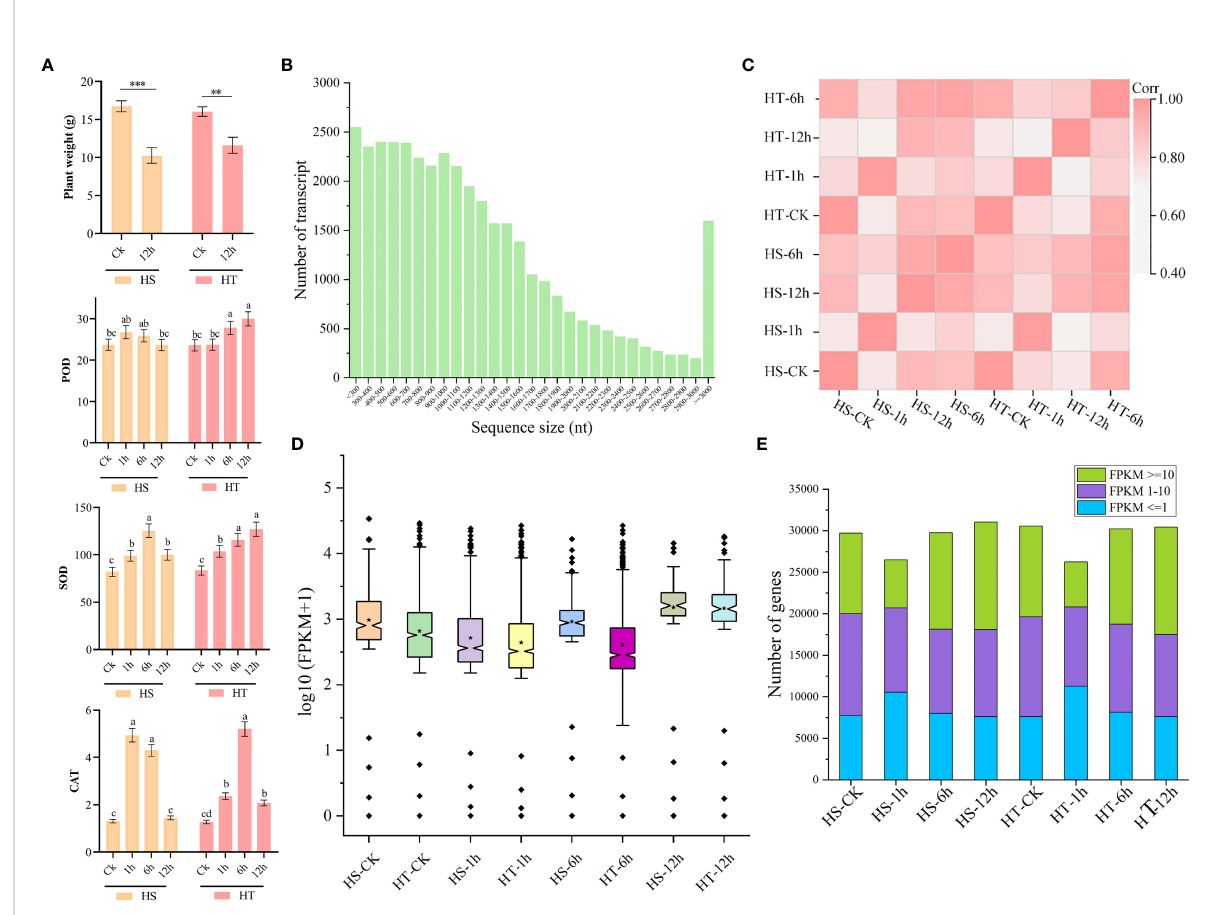
FIGURE 1 Phenotypic effect and overview of RNA sequencing data based on heat-sensitive and heat-tolerant fl owering Chinese cabbage varieties. (A) Plant weight and enzymatic activities between control and stress conditions; (B) Number of transcripts and their sequence size; (C) Correlation analysis between heat-sensitive and heat-tolerant varieties at different time points; (D) log 10 transformation of FPKM values at 0, 1, 6, and 12 h; (E) Distribution of genes based on FPKM values. The different small letters indicate the signi fi cant differences between the time